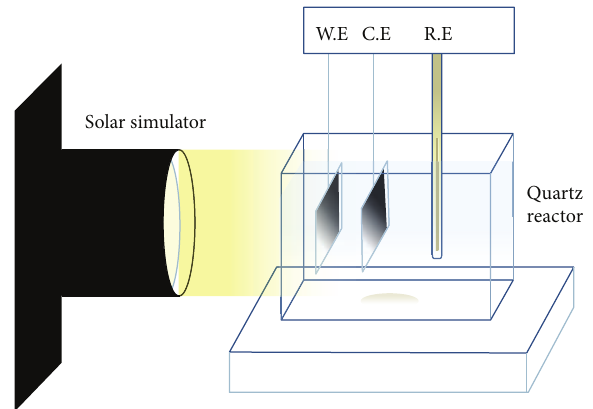
Figure 2: Quartz made photoelectrocatalytic (PEC) reactor with solar simulator.